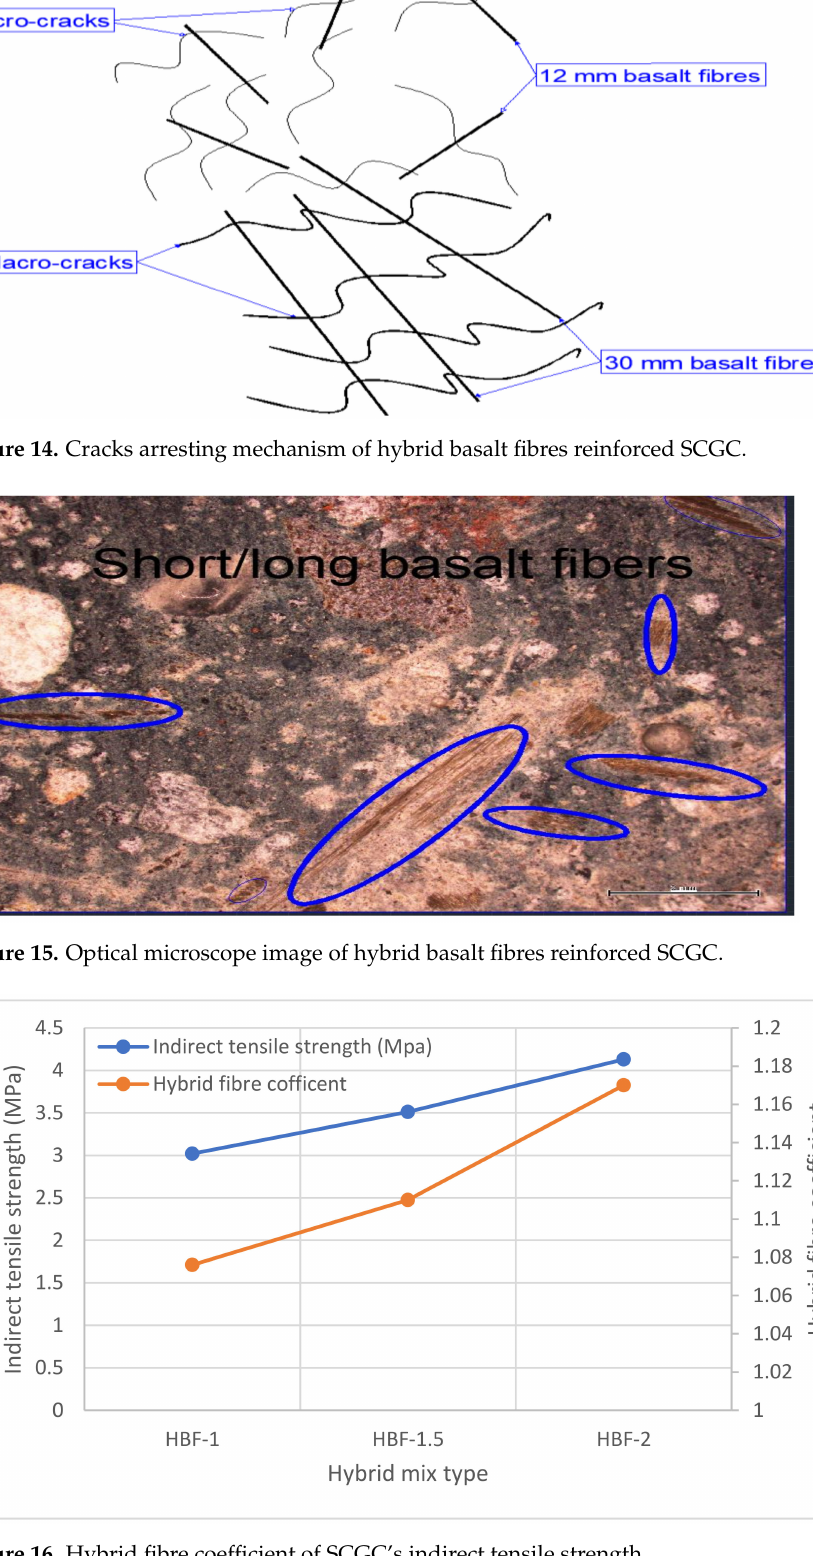
Figure 16. Hybrid fibre coefficient of SCGC’s indirect tensile